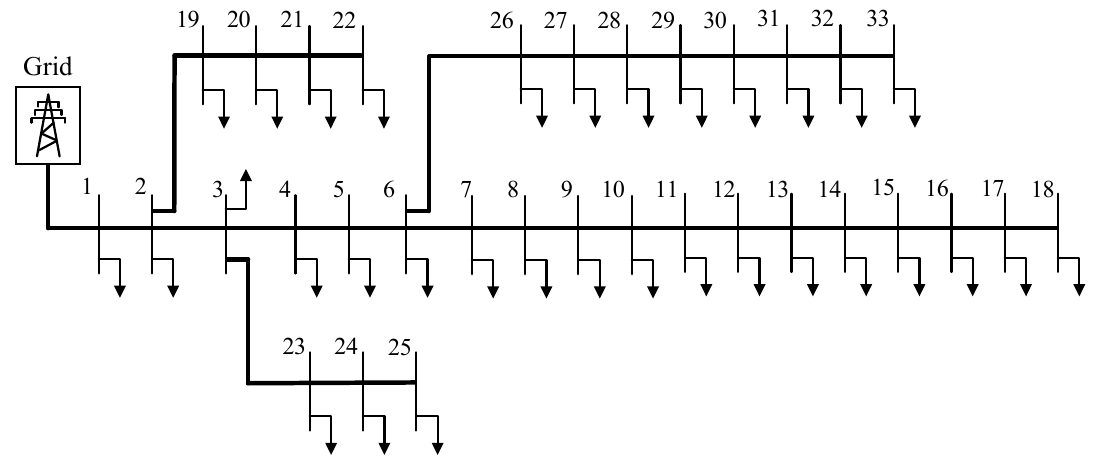
Figure 2. IEEE 33-Bus Distribution System [33].